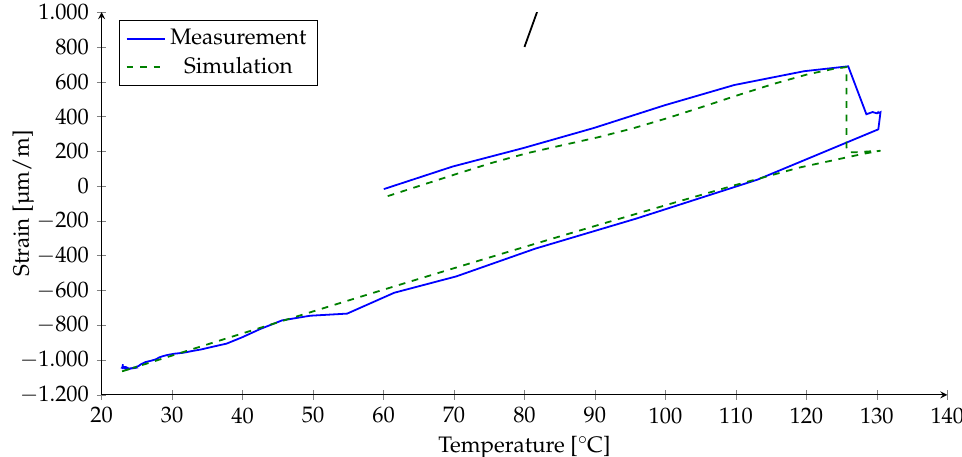
Figure 13. Comparison of the simulated and measured strain in dependency on the temperature of the post-curing step of panel